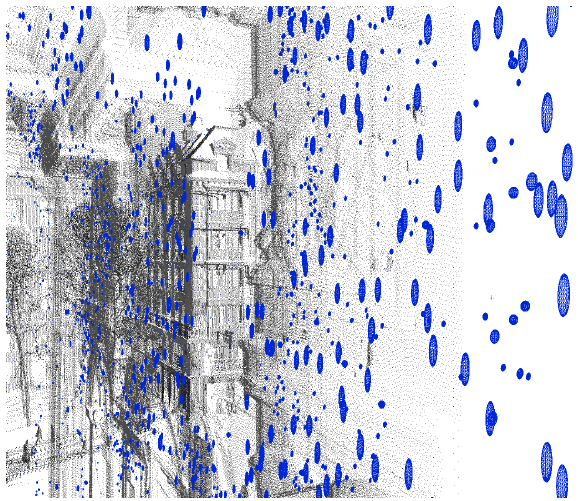
Figure 5: Black : points cloud of the mobile terrestrial LiDAR , blue : error ellipsoids. An error ellipsoid every 150 points